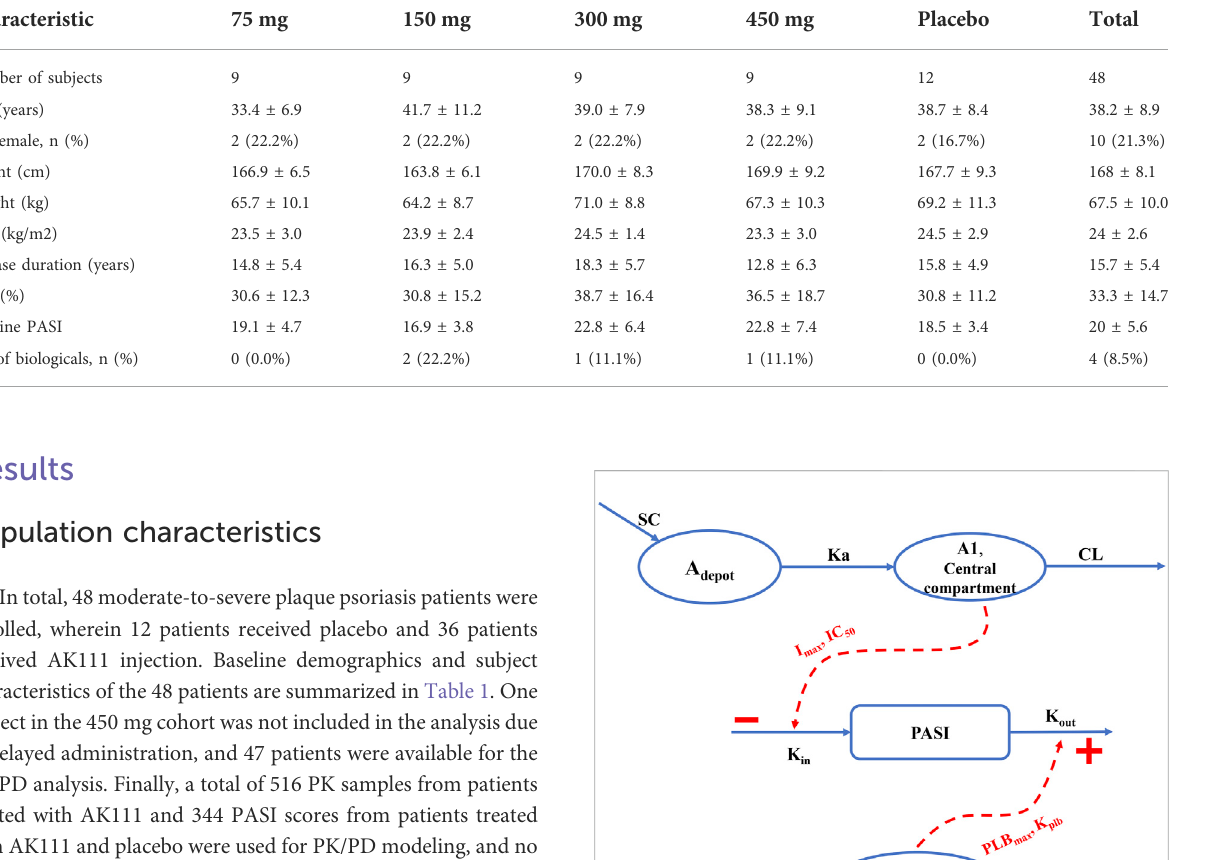
TABLE 1 Demographic and baseline characteristics (mean ± SD).